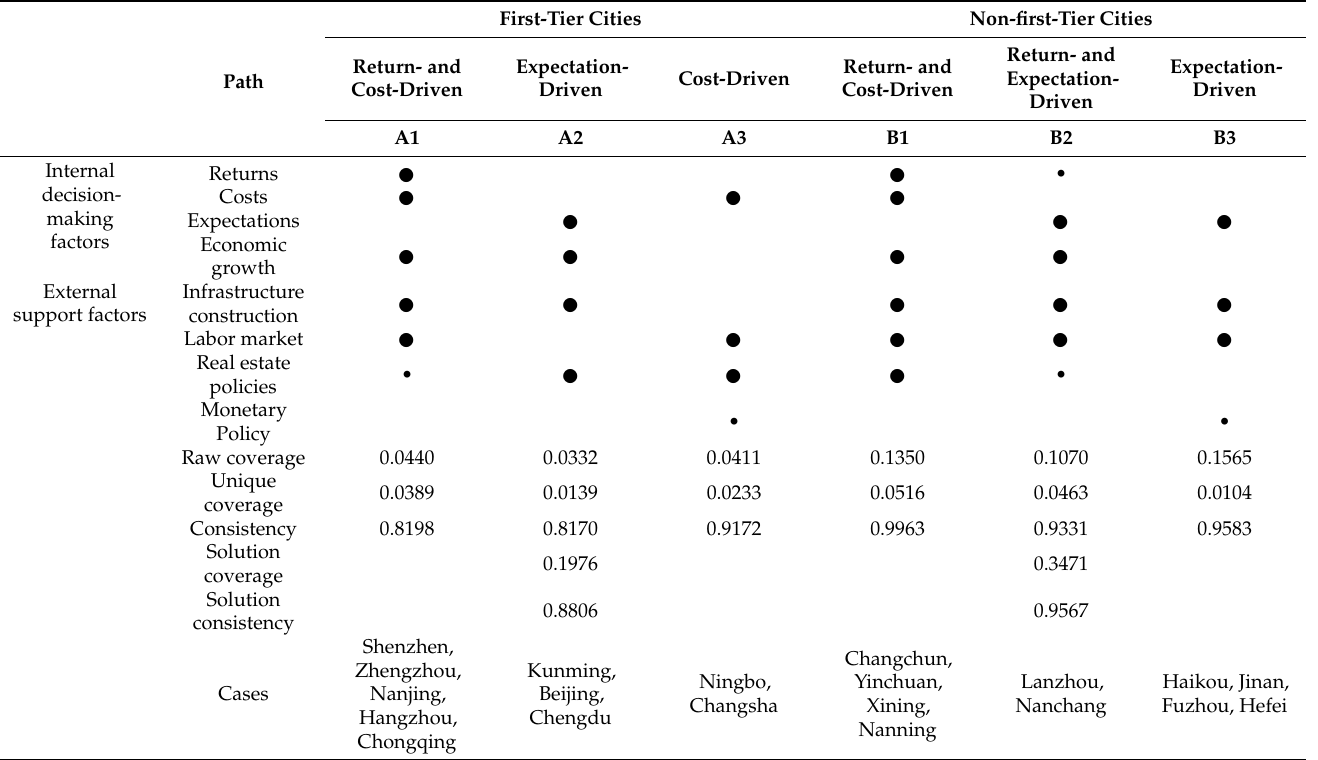
Table 3. Configuration path analysis of high-level housing investment resilience in first-tier and non-first-tier